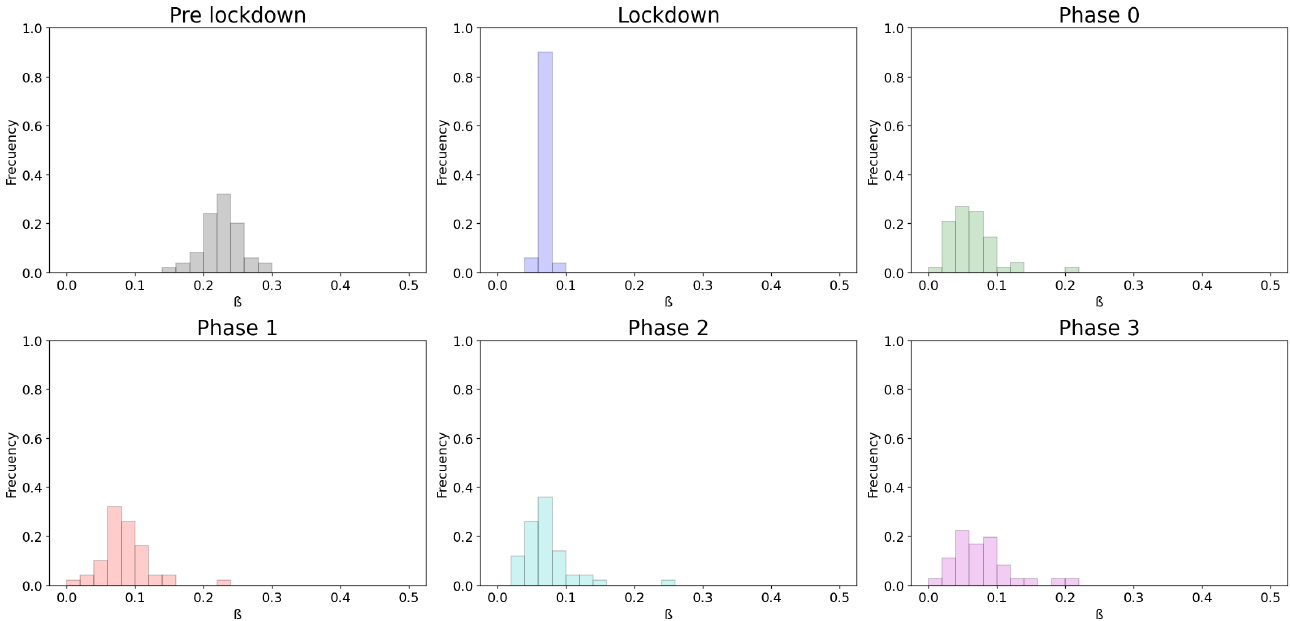
Figure 5. A distribution of the values for β for the different stages of lockdown in the different provinces of